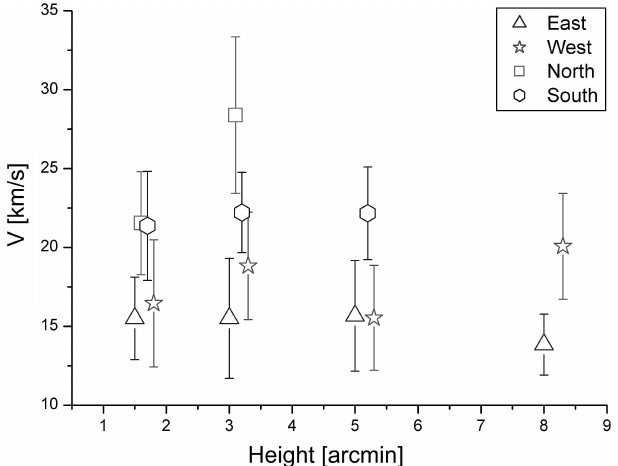
Fig. 8. Radial variations of the turbulent (non-thermal) isotropic velocities, assuming a temperature of 1.8MK for the Fe XIV ions. Uncertainty bars correspond to the dispersion obtained along each slit length, not to the significantly smaller intrinsic uncertainties.